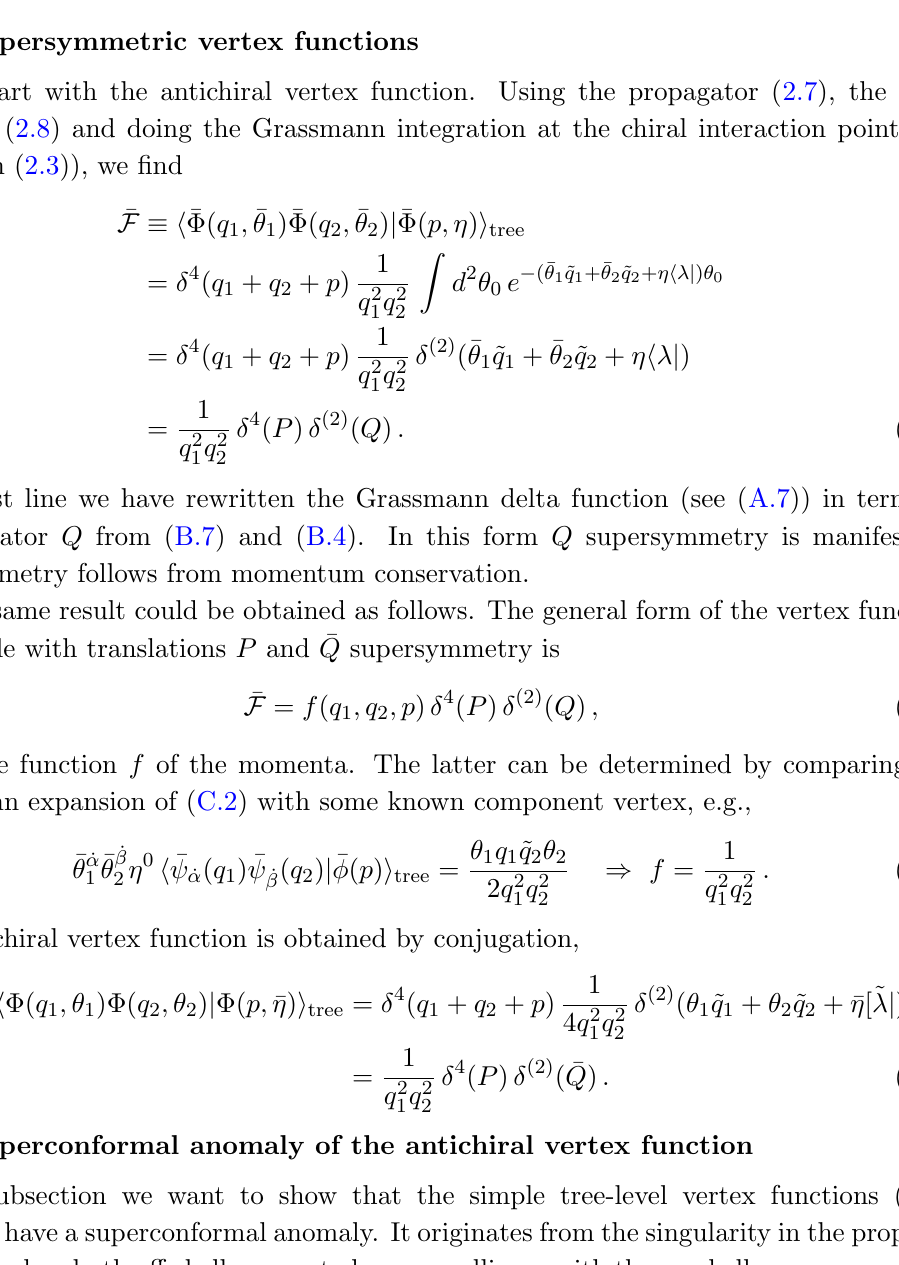
(cid:22) (cid:18) (cid:22) (cid:18) (cid:22)(cid:8)( q )(cid:22)(cid:8)( q (cid:22)(cid:8)( p; (cid:17) ) 1 ; 1 2 ; 2 ) j h